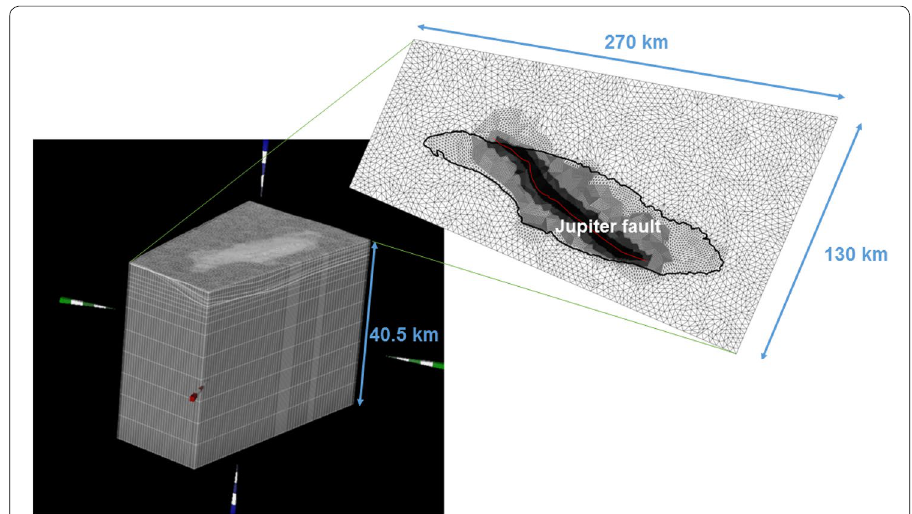
Fig. 7 Mesh in FEFLOW for the 3D numerical heat transfer model